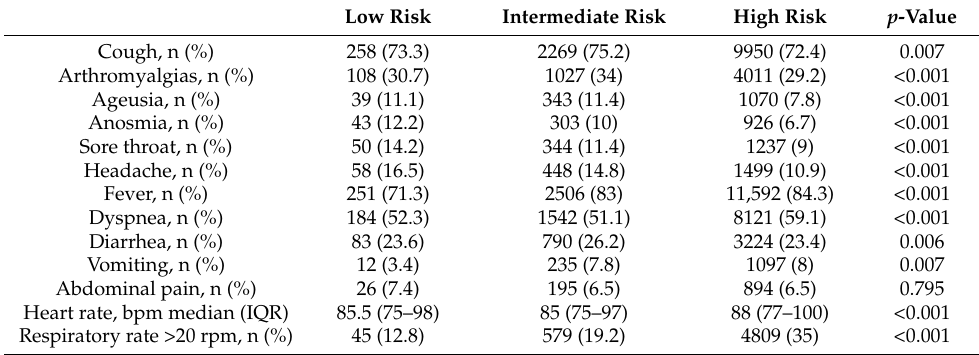
Table 3. Symptoms and physical examination upon admission for the three